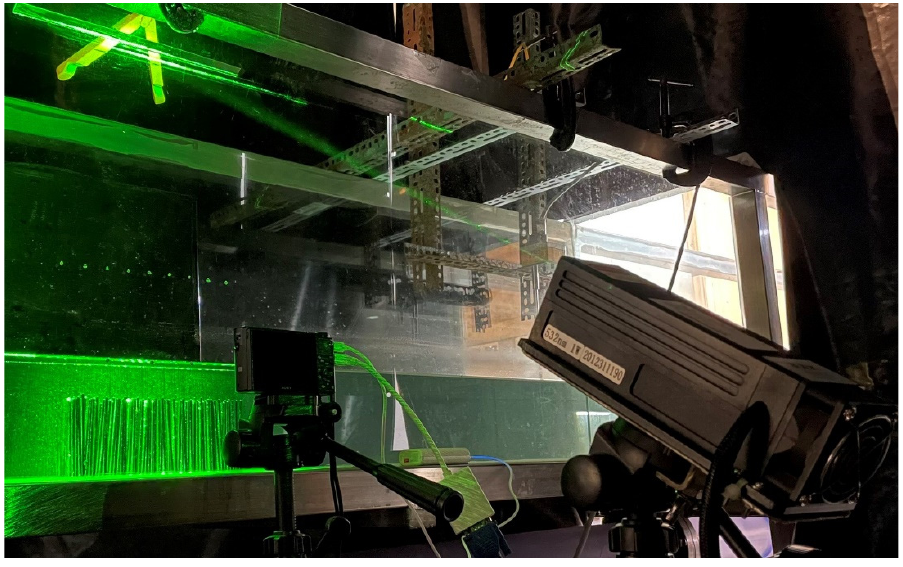
Figure 1. Photographs of experimental set-up.